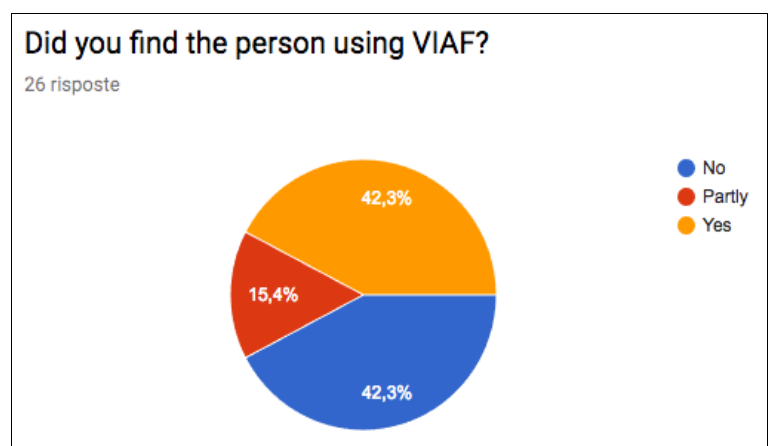
Figure 12. Information on people retrieved via